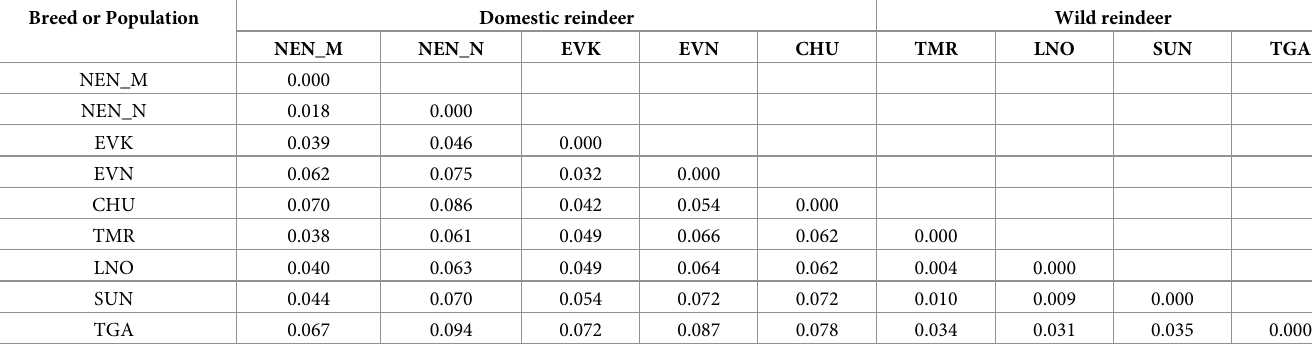
Table 2. Genetic differentiation of domestic and wild reindeer populations measured by F ST values. Breed or Population Domestic reindeer Wild